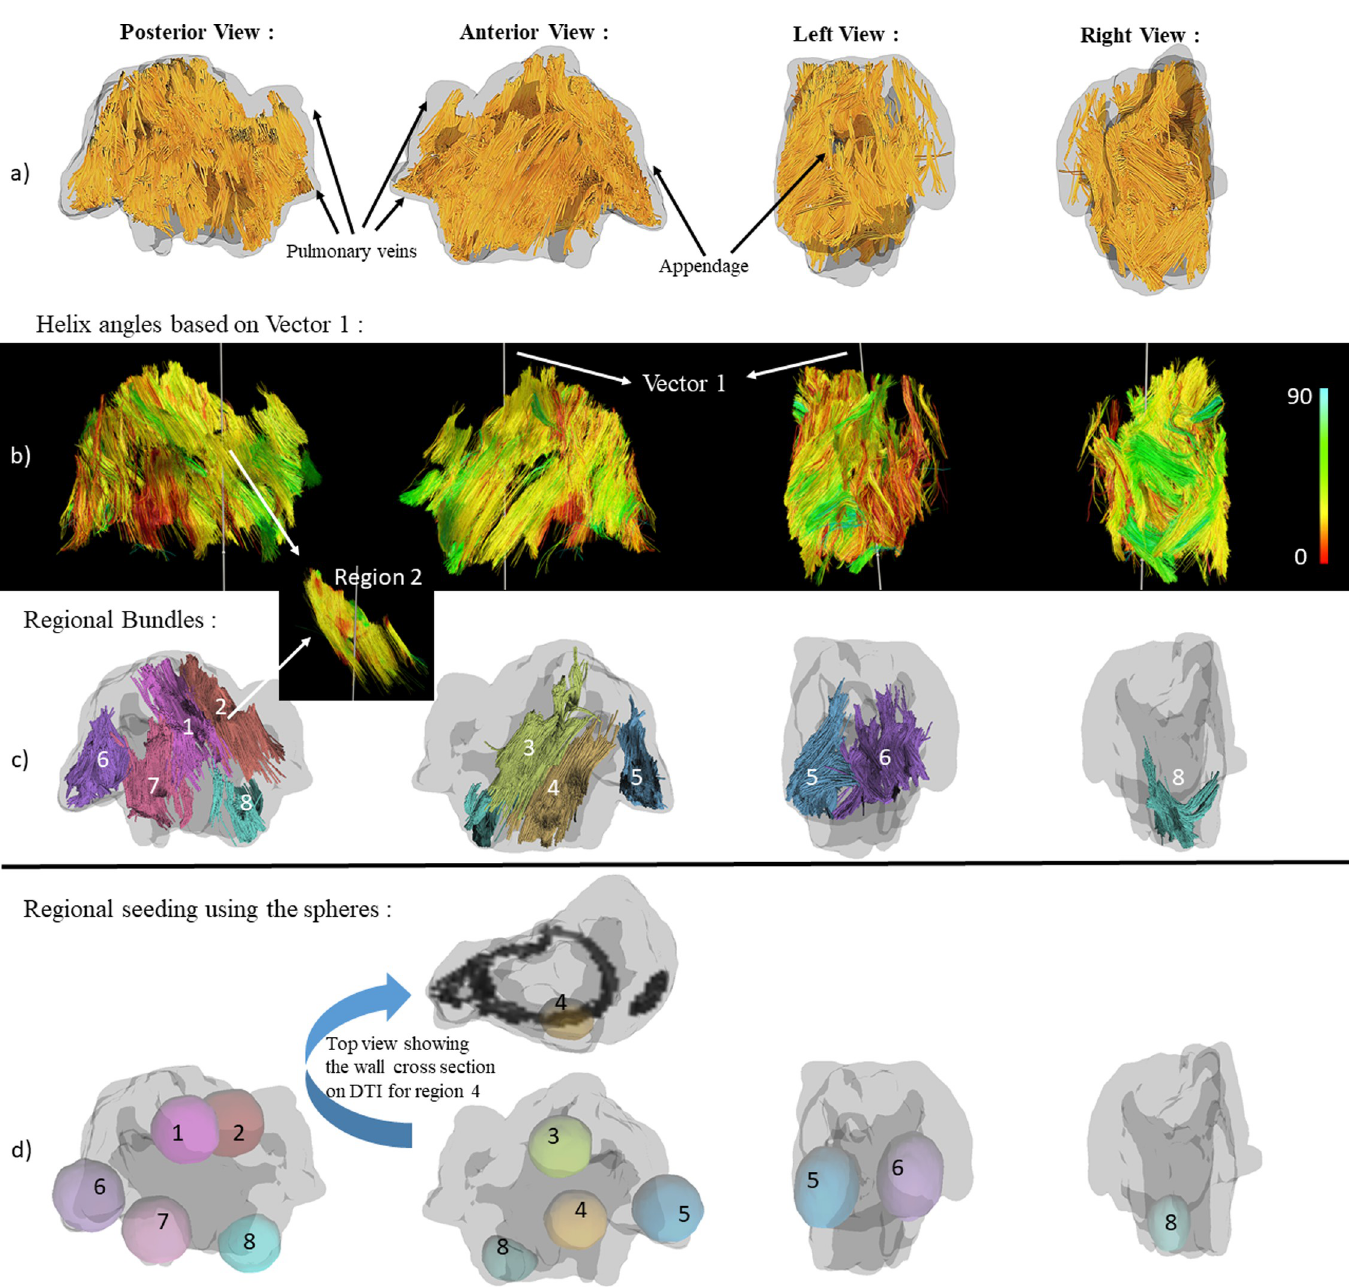
Fig 2. DTI based fiber orientation. a) Different views of the left atrium in one animal with the 3D fiber orientation before region selection. b) Fiber orientations color coded with helix angle (from 0 to 90 degree) with the vector perpendicular to the mitral valve plane (vector 1) chosen as the reference vector. c) Fibers in the eight different selected regions, each with a different color. d) Spheres chosen for regional seeding of the regions shown with different colors. https://doi.org/10.1371/journal.pone.0279974.g002 and MD for the non-inducible group was 0.32 ± 0.08 and 8.54 ± 1.72 mm 2 /s, and for the induc- ible group 0.31 ± 0.05 (P-value = 0.90), and 8.68 ± 1.60 mm 2 /s (P-value = 0.88), respectively, showing no significant difference in diffusion anisotropy pattern or the presence of inflamma- tion or edema between the two groups.